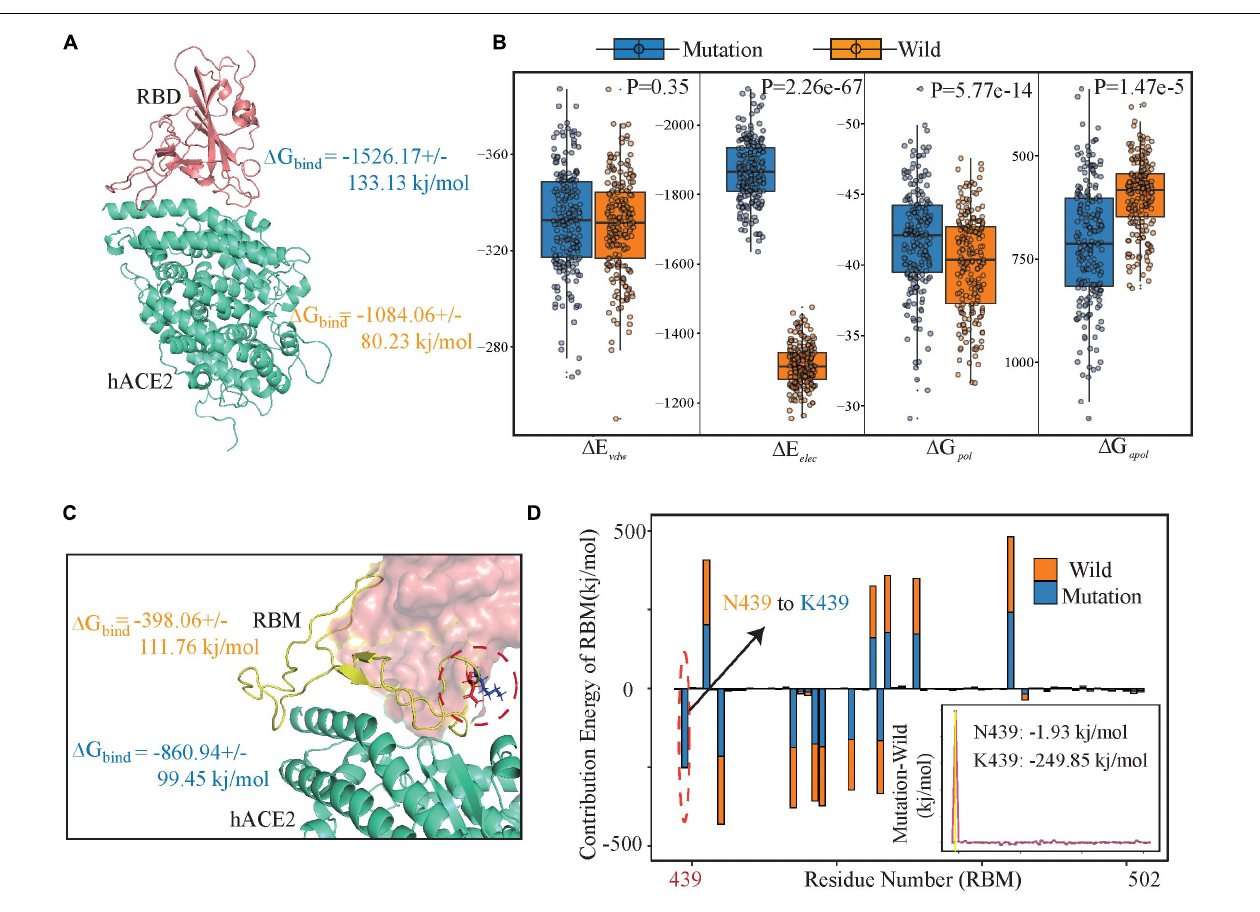
FIGURE 3 | Energy components for binding free energy of both wild and mutated RBD/RBM-hACE2 complexes. (A) The binding free energies for SARS-CoV-2 RBD-hACE2 (including wild type and variantN439K) using MM-PBSA. Total binding energy ( (cid:49) Gbind). (B) Energy components for the binding free energy of RBD-hACE2. The intermolecular van der Waals ( (cid:49) Evdw); Electrostatic interactions ( (cid:49) Eelec); Polar solvation energy ( (cid:49) Gpol) and apolar (non-polar) solvation energy ( (cid:49) Gapol). (C) The binding free energies for SARS-CoV-2 RBM-hACE2 (including wild type and variant N439K), using orange for wild-type and blue for mutant type. (D) Decomposition of (cid:49) Gbind into contributions from individual residues (438–502) of RBM before and after mutation. All units are reported in